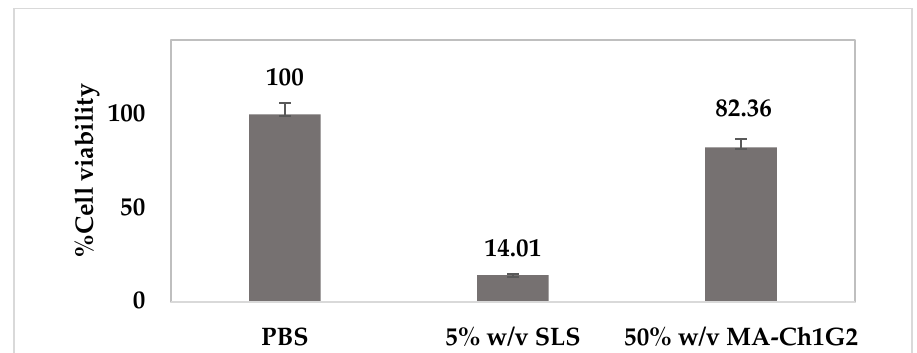
Figure 3. The percentage of cell viability after treatment with 50% w/v M. alba callus extracts from Ch1G2 (MA-Ch1G2), PBS and 5% w/v SLS as negative and positive controls, respectively. (mean ± SD, n = 3).